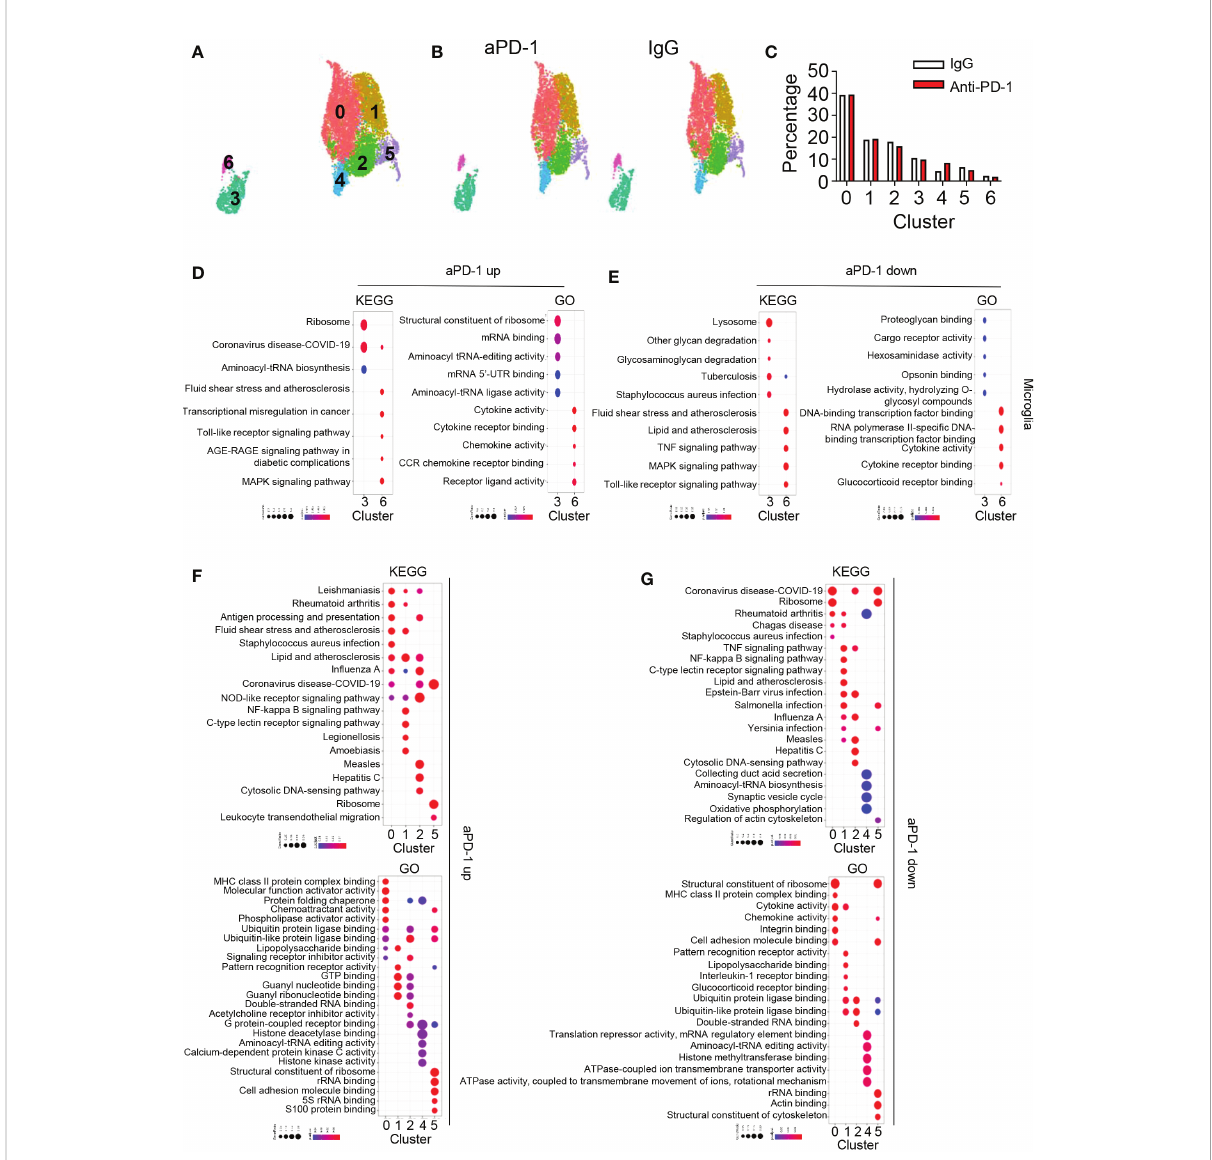
FIGURE 5 aPD-1 – mediated alteration of microglia and macrophage transcriptomes. (A) Microglia, macrophage 1, and macrophage 2 clusters from Figure 1 were isolated and re-clustered. Seven different clusters were identi fi ed. (B, C) Changes in clusters of microglia and macrophages are shown by DimPlot (B) and bar graph (C) . (D, E) Dot plots for KEGG and GO pathways that were upregulated (D) or downregulated (E) by aPD-1 treatment in microglia (clusters 3 and 6). (F, G) Dot plots for KEGG and GO pathways that were upregulated (F) or downregulated (G) by aPD-1 treatment in macrophage clusters (clusters 0, 1, 2, 4, and 5). ns, not signi fi